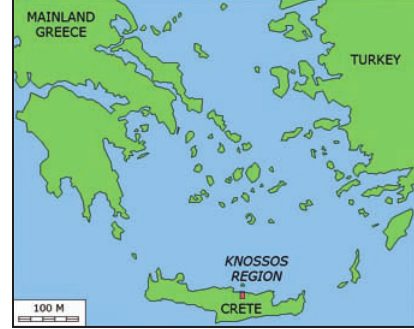
Figure 1 Crete and the Knossos area, within the southern Aegean.